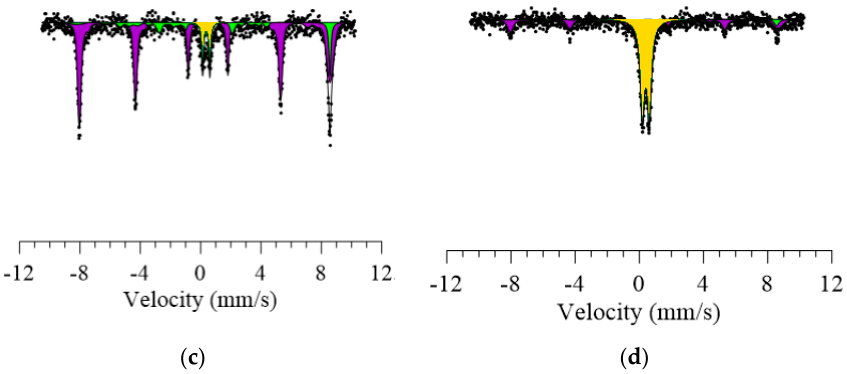
Figure 8. Mössbauer spectra of nanoparticles: ( a ) FeCeO x nanoparticles; ( b ) 0.9FeCeO x + 0.1Nb 2 O 5 nanoparticles; ( c ) 0.8FeCeO x + 0.2 Nb 2 O 5 nanoparticles; and ( d ) 0.7FeCeO x + 0.3 Nb 2 O 5 nanoparticles.